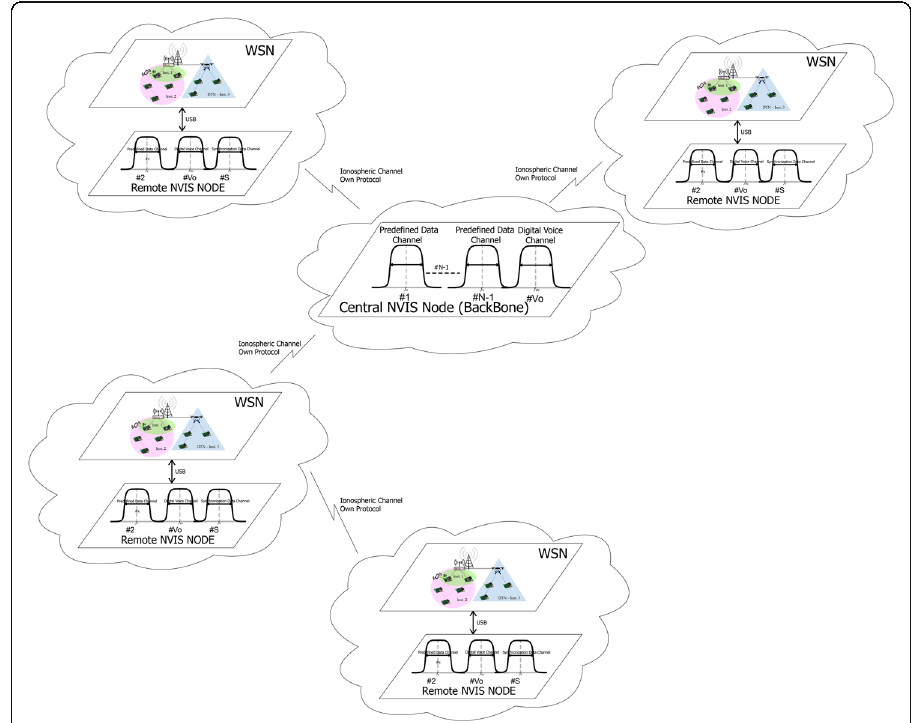
Fig. 13 HLD NVIS network distribution. Schematic of how the network is distributed to communicate the sensors data from the WSN collected by a NVIS remote node to the